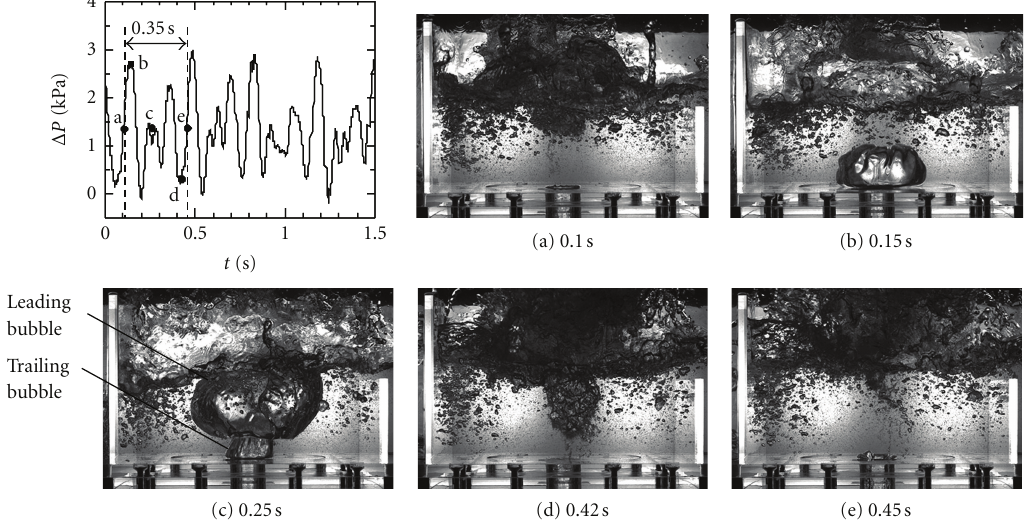
Figure 8: Bubble generation process in the rectangular tank ( J G = 4 . 9 m/s, J G ∗ 1 / 2 = 0 . 50, Ku G 1 / 2 = 1 . 0, and D = 45mm).